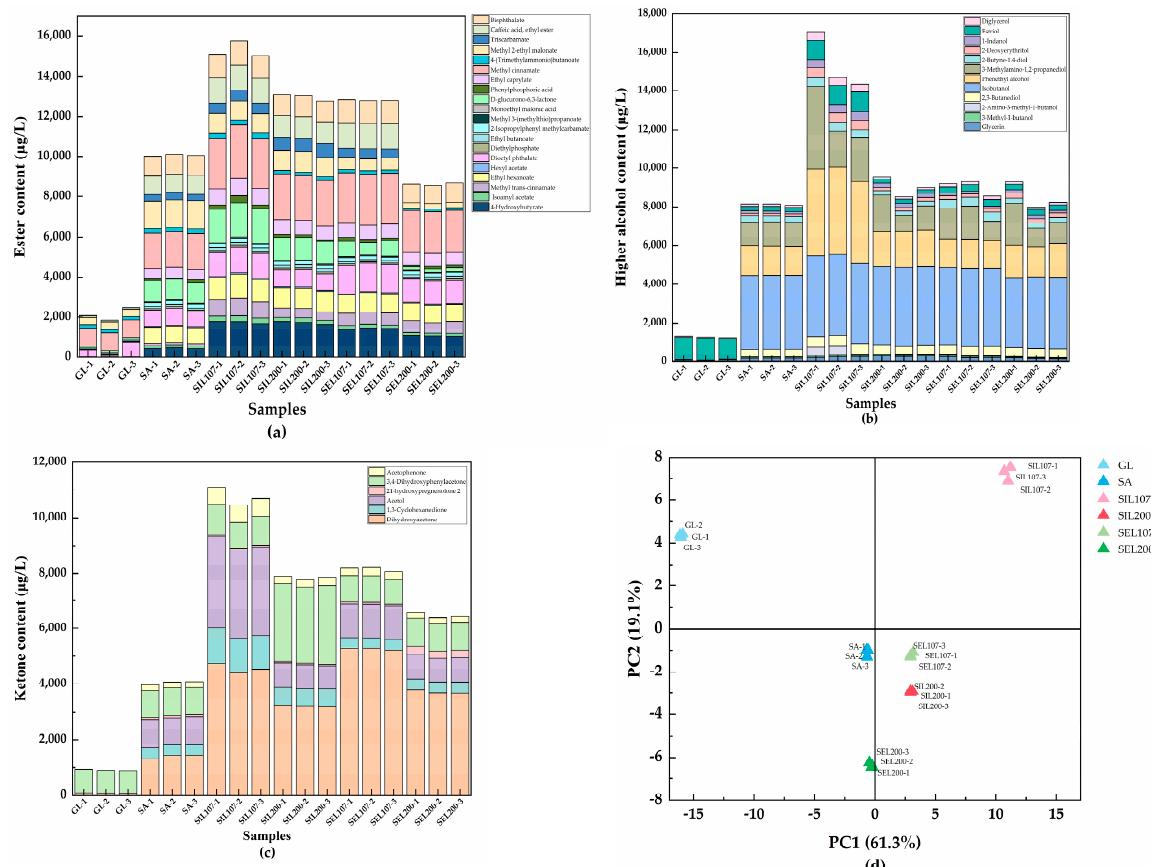
Figure 4. Volatile compound analysis in apple juice and ciders fermented by single and mixed cultures. The contents of esters ( a ), higher alcohols ( b ), and ketones ( c ) in apple juice and ciders. ( d ) Principal component analysis (PCA) based on volatile compounds in apple juice and apple ciders.